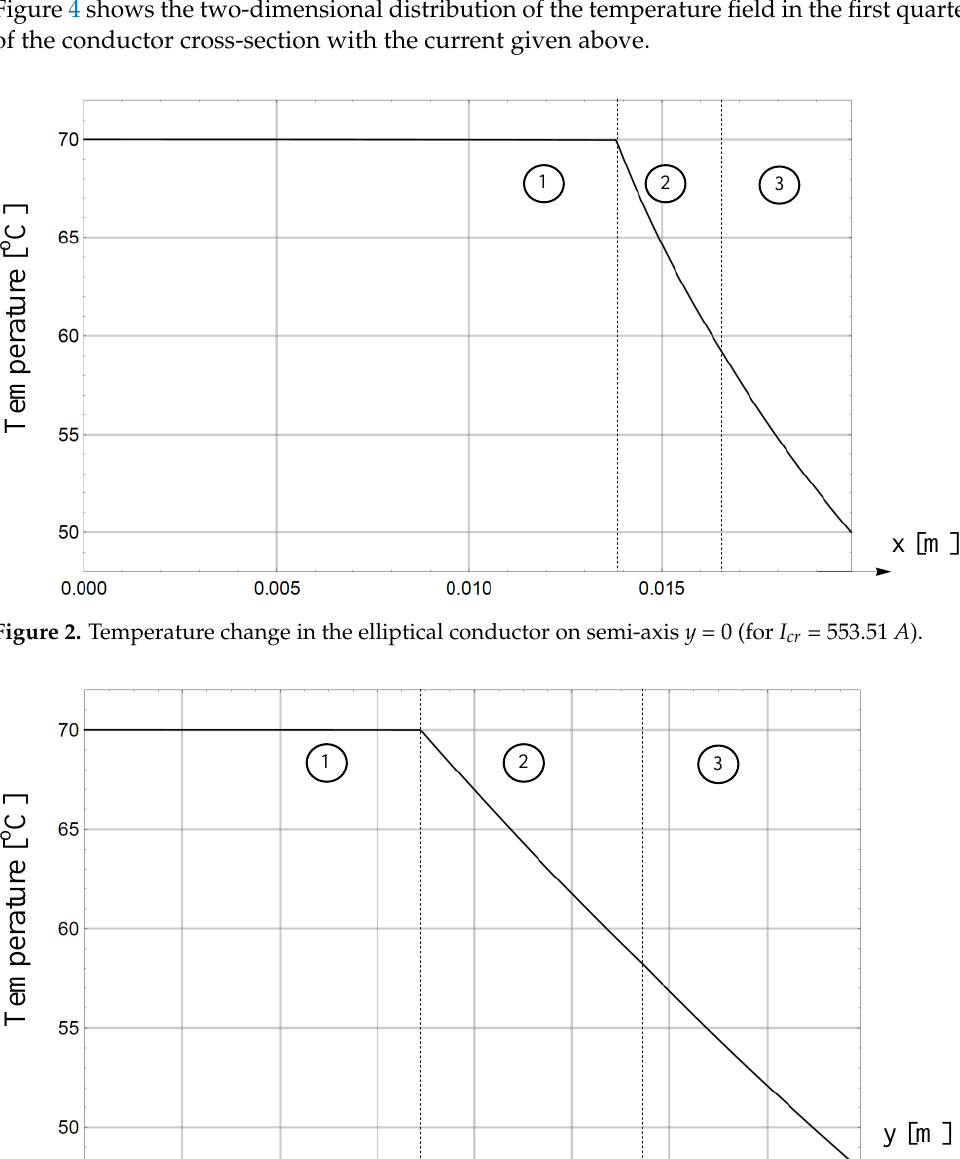
Figure 4. Temperature field distribution in the first quarter of the cross-section of the elliptical con- ductor (for I cr = 553.51 A ).